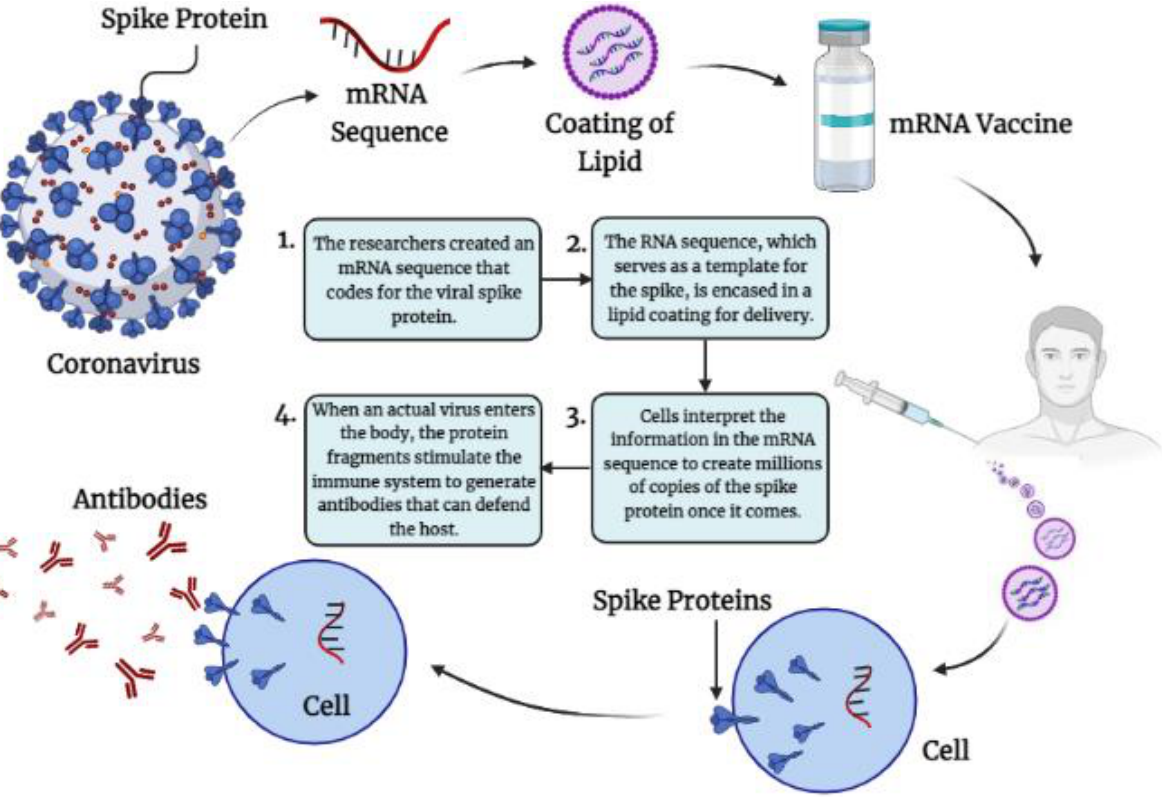
Figure 1. Shows how an RNA vaccine works against